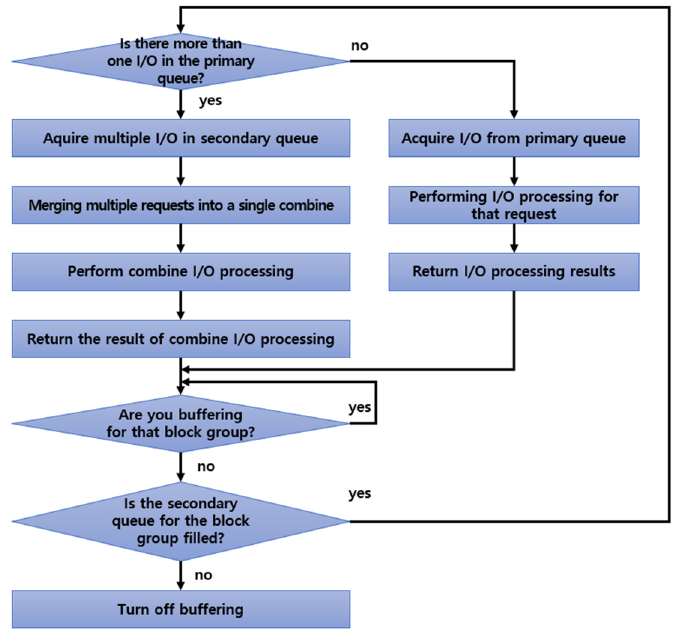
Figure 9. I/O combining step.